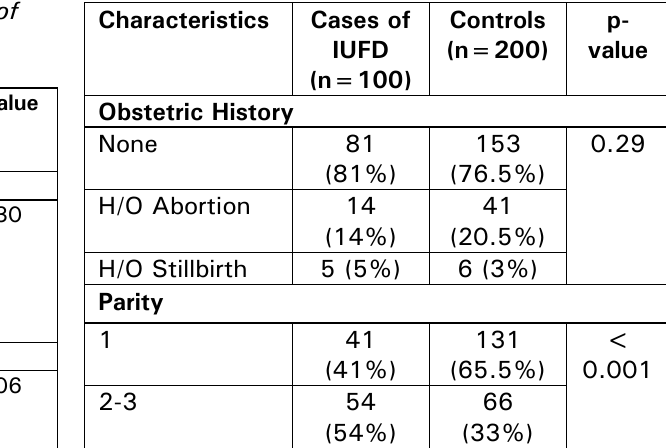
Table 3: Obstetric Characteristics of